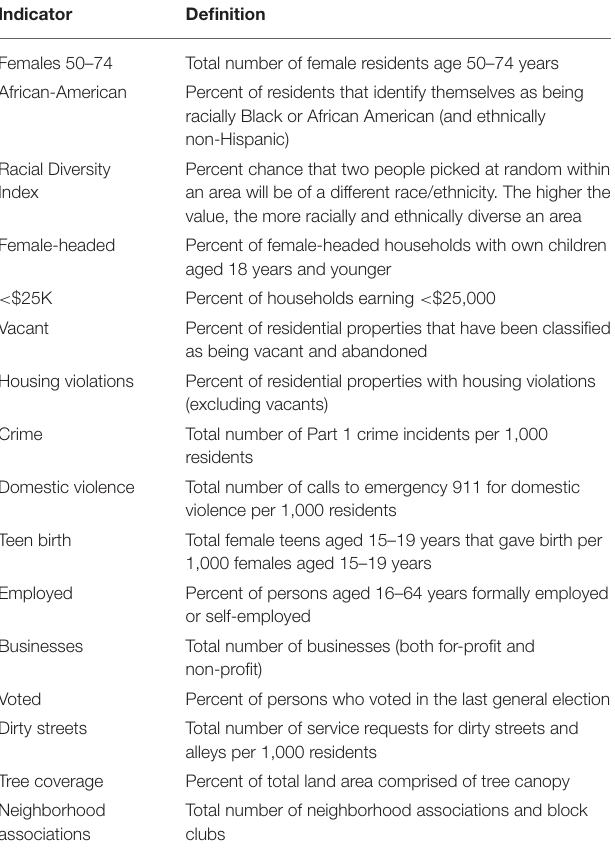
TABLE 1 | Definitions of community statistical area